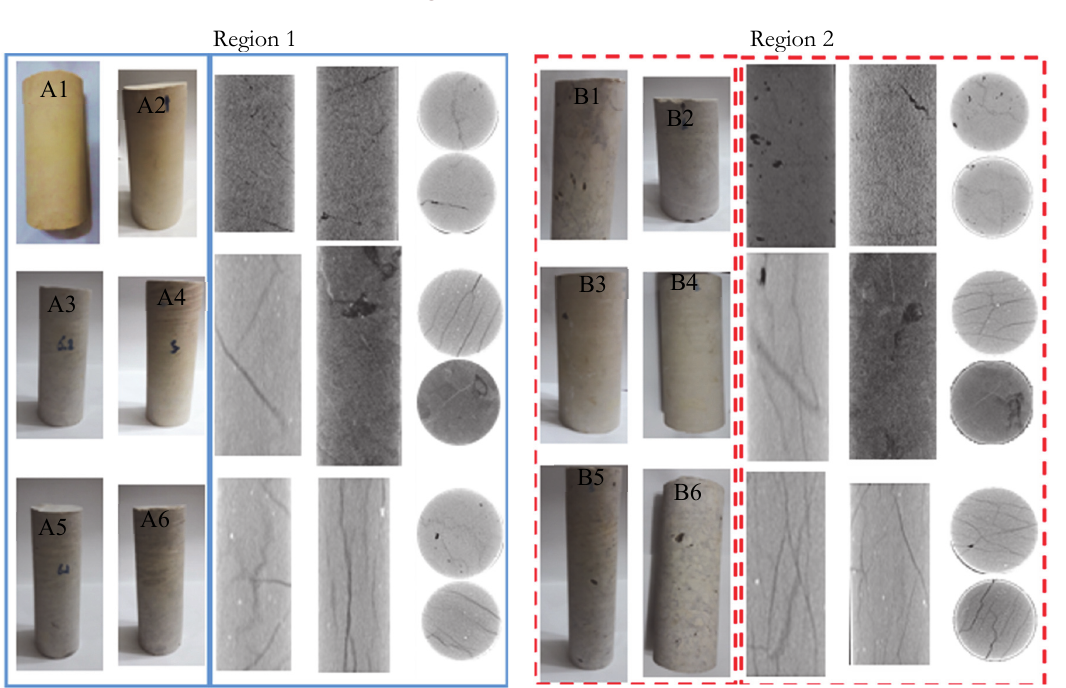
Figure 4: CT-Scan devise, core samples, and digital images output of the